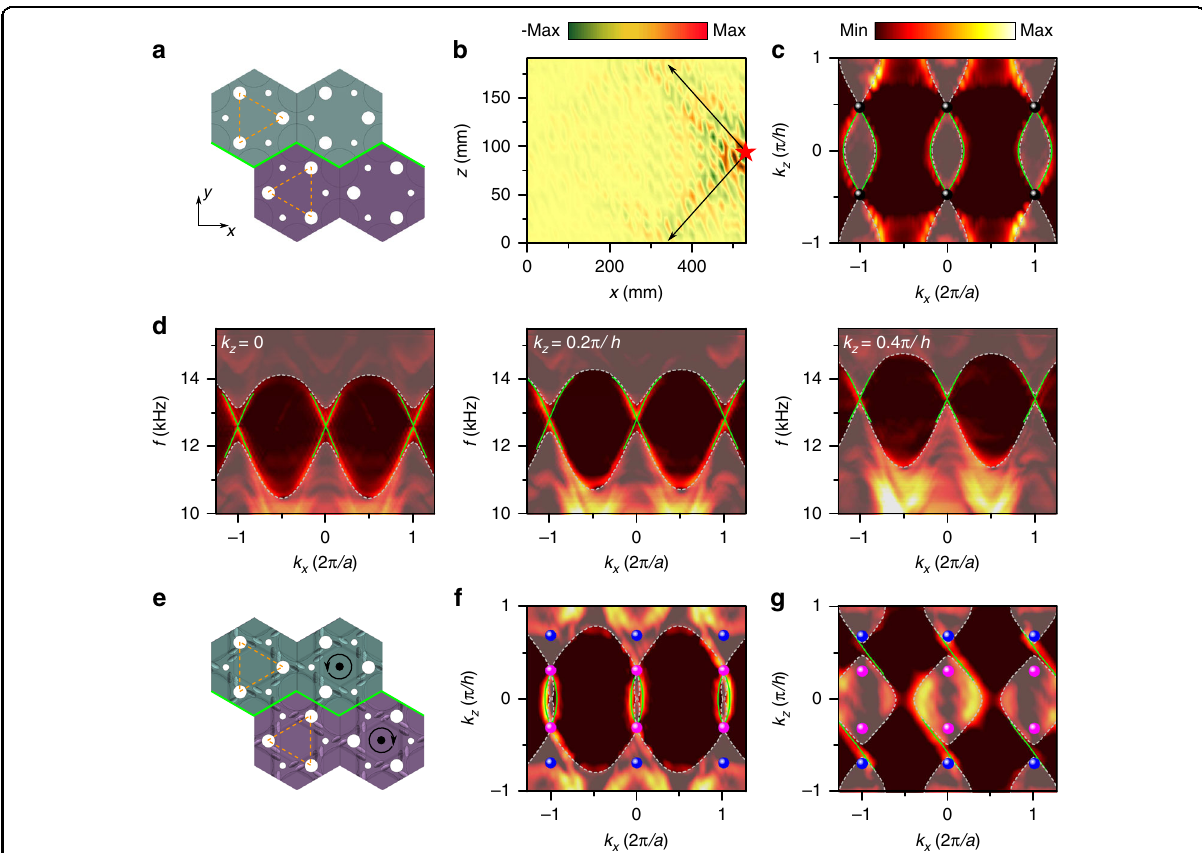
Fig. 4 Observation of helical interface states in the 3D Dirac sonic crystal. a Schematic of the interface formed by swapping the large and small tubes. b Measured real-space interface wave propagation excited by a point-like source at the Dirac frequency. The position of the sound source is indicated by a red star. c Fourier-transformed equifrequency contours for the data in b . The black spheres represent the projections of the Dirac points. d Interface band dispersion for k z ¼ 0, 0.2 π = h and 0.4 π = h . The green solid lines represent the simulated interface states. The shaded areas represent the calculated projected bulk bands. e Schematic of the interface formed by swapping the large and small tubes and inverting the chirality of slanted tubes of the Weyl sonic crystal. f , g Equifrequency contours at f WP1 frequency and at g Dirac